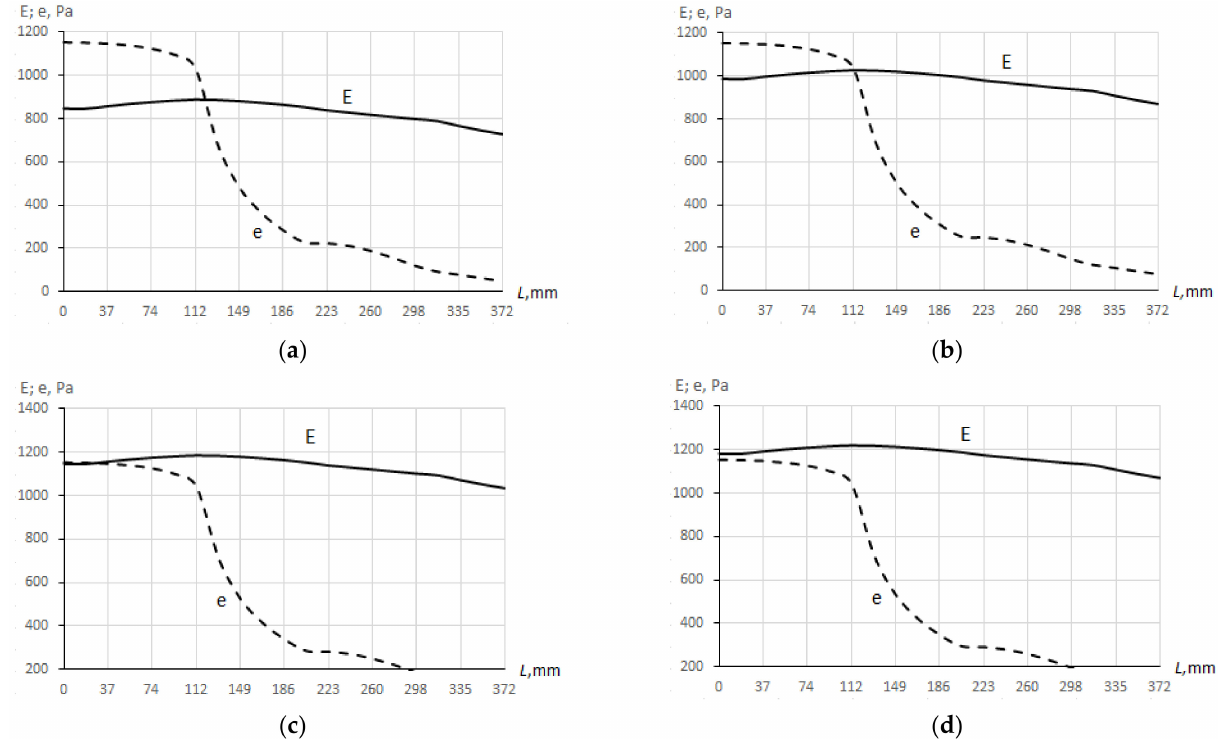
Figure 13. Graphs of changes in the partial pressure of water vapor e and partial pressure of saturated water vapor E in the area of metal structures that are not in contact with the attic air at a relative humidity in the attic of 30% and its temperature: ( a ) − 15 °C; ( b ) − 10 °C; ( c ) − 5 °C; and ( d ) − 4